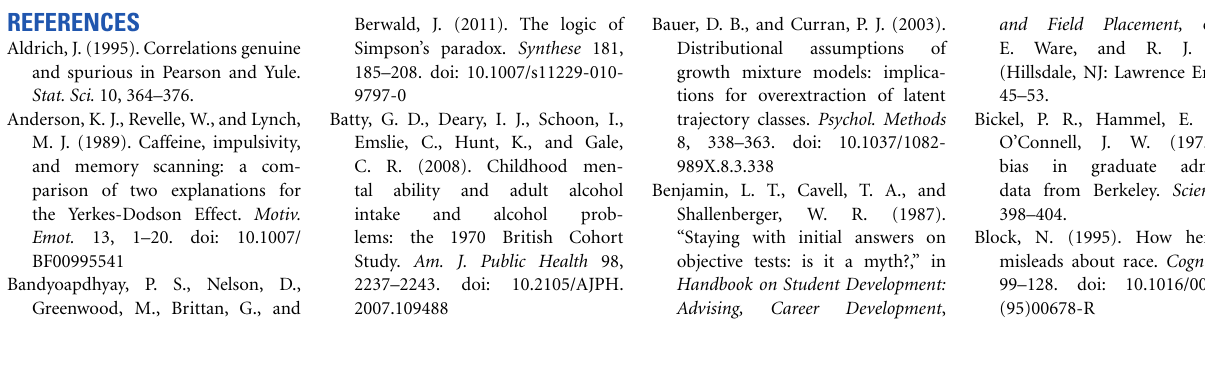
significant positive association between coffee and